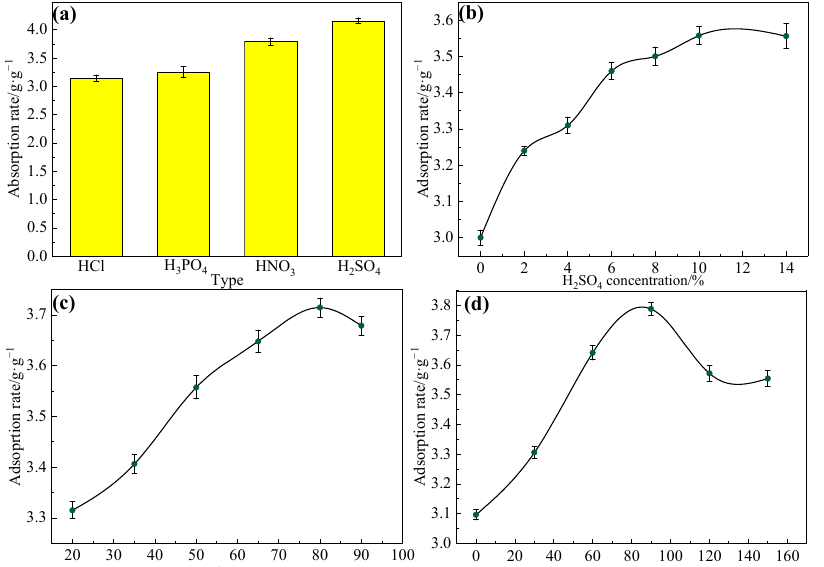
Figure 2. ( a ) E ff ect of acid type under the concentration of 10%, and reacting for 90 min at 80 °C. ( b ) Figure 2. ( a ) Effect of acid type under the concentration of 10%, and reacting for 90 min at 80 ◦ C. E ff ect of H 2 SO 4 concentration under reacting for 90 min at 80 °C. ( c ) E ff ect of acid treatment ( b ) Effect of H 2 SO 4 concentration under reacting for 90 min at 80 ◦ C. ( c ) Effect of acid treatment temperature under the concentration of 10% H 2 SO 4 and reacting for 90 min. ( d ) Effect of acid treatment time under the concentration of 10% at 80 ◦